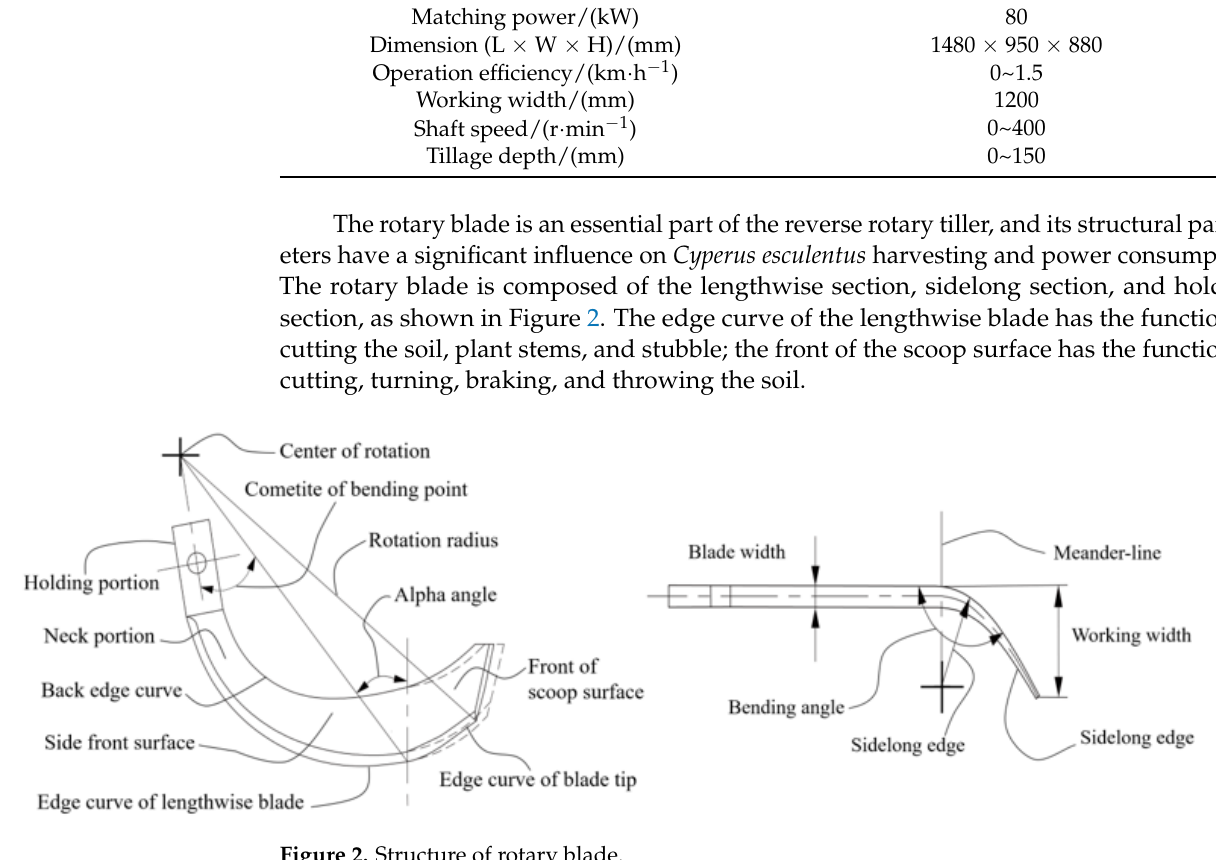
Figure 2. Structure of rotary blade.